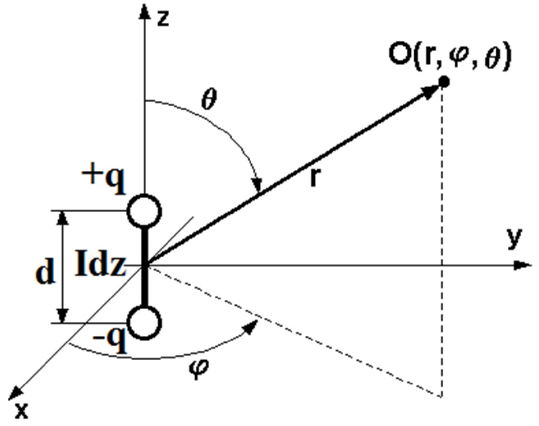
Figure 2. Model of electromagnetic wave propagation from an elementary electric dipole.